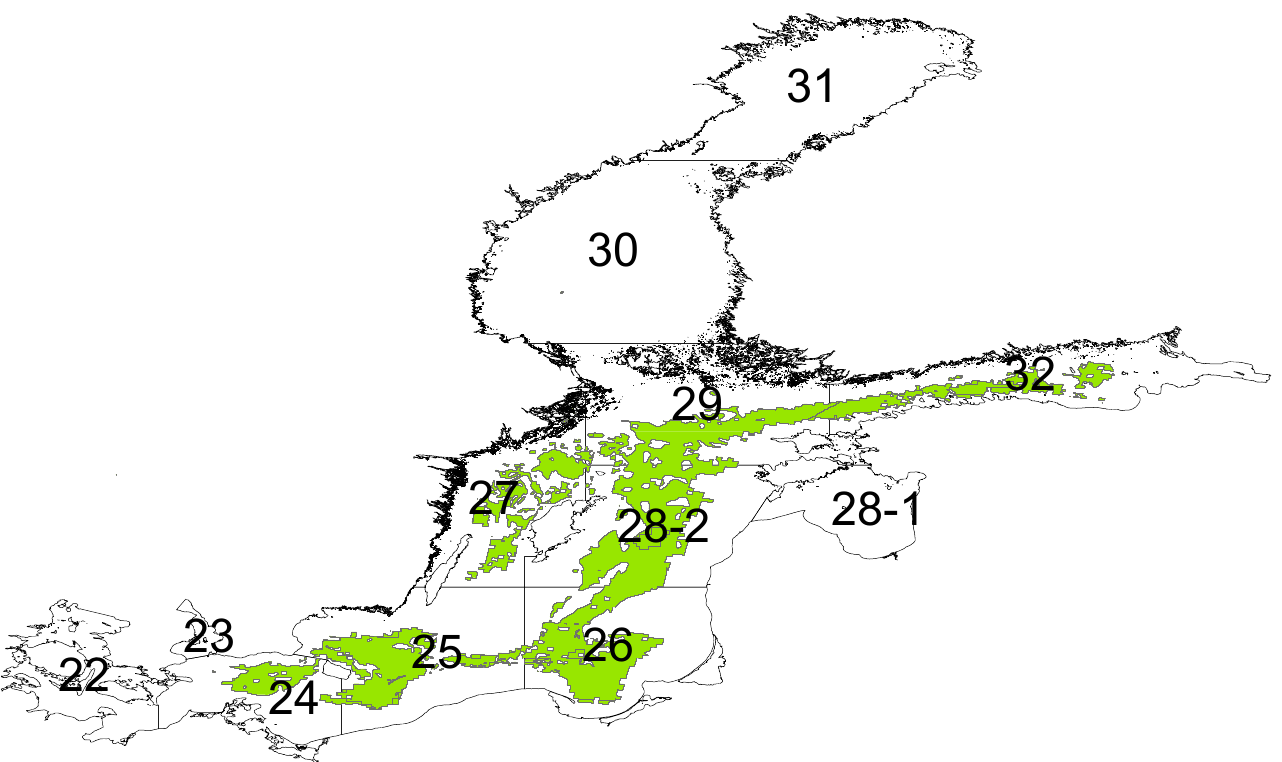
Figure 7. Spatial map of ICES subdivisions with biotopes that have the shelf mud grouped class